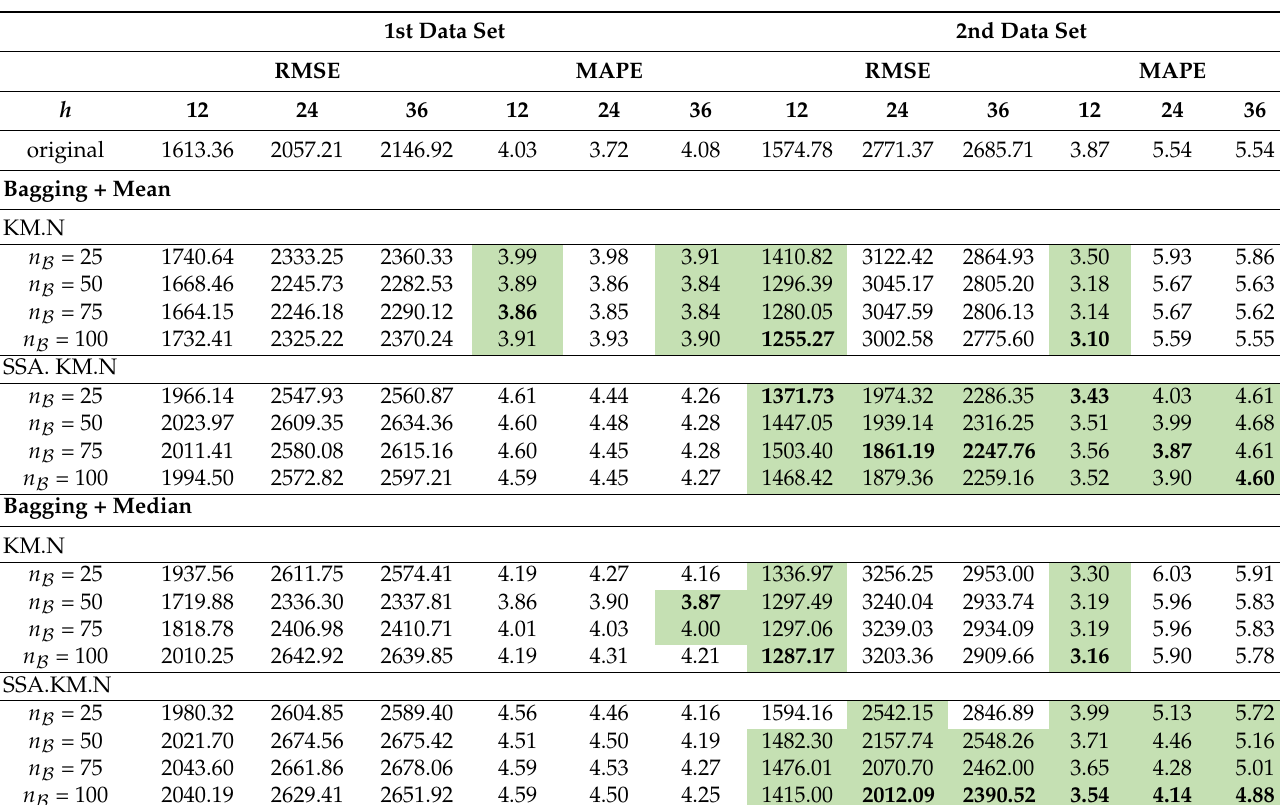
Table 5. RMSE and MAPE of h -step ahead forecast obtained by TBATS model from the original series, KM.N and SSA.KM.N bootstrap